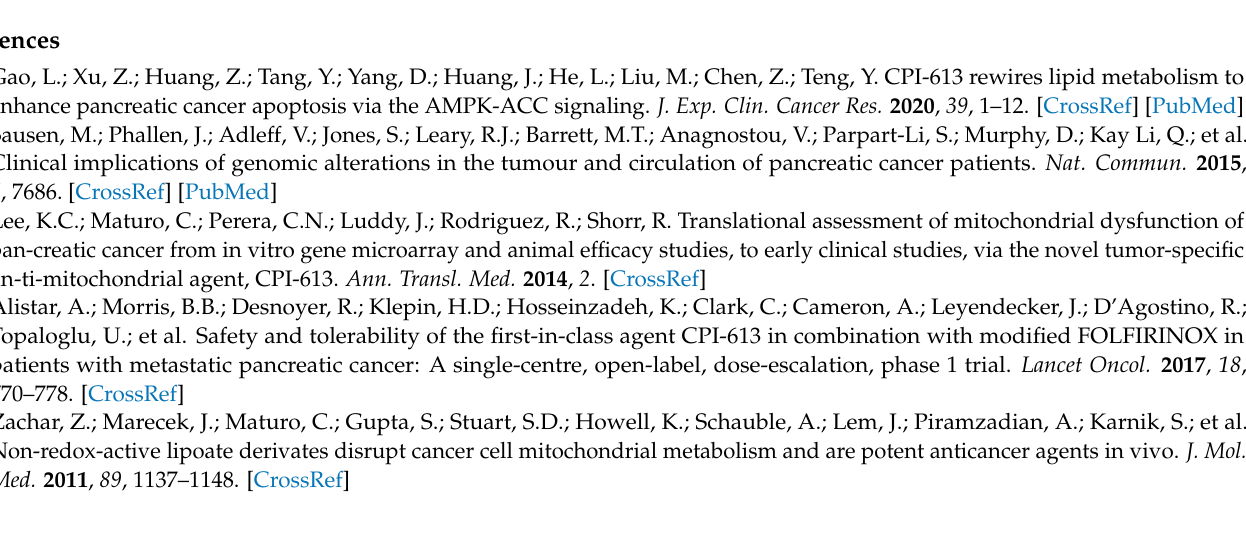
at room temperature). Data represent mean ± SD ( n = 3). Figure S3: Zeta-potentials of TTCI NPs constructed with TTCI :DSPE-PEG2000 at a molar ratio of 1:0.2 (DLS at room temperature). Figure S4: Size distribution of TTCh NPs after treatment with 700 mM H 2 O 2 for different times. Figure S5: Images of the BxPC-3 cells treated with Rhodamine B-loaded TTCI / Rho NPs at a concentration of 20 µ M for 0.5, 2, and 4 h, respectively. For each row, left: TTCI / Rho NPs; middle: bright field; right: merged image. The images were captured by high content analysis system-operetta CLS TM (A). Scale bars: 50 µ m. The mean intensity of rhodamine fluorescence in the images at different incubation times as calculated using imageJ software (B). Figure S6: Mitochondria-targeting ability of TTCI / NR NPs in vitro: Images of the BxPC3 cells treated with TTCI / NR NPs at the concentration of 20 µ M for 0.5, 2 and 4 h captured by high content analysis system-operetta CLS TM . For each row, from left to right: TTCI / NR NPs; mitochondria stained by MitoTracker Green; merged image. Scale bars: 50 µ m. Figure S7: Cell viability of AsPC-1 (A) and PANC-1 (B) cells after being treated with different concentrations of TTCI NPs and TTCh NPs for 48 h. Data represent mean ± SD ( n = 3). Figure S8: Digital phase contrast images of living BxPC-3 cells (D) treated with PBS, 20 µ M TTCI NPs, 50 µ M TTCI NPs and 50 µ M CPI-613 at different times. Digital phase contrast images were captured by high content analysis system-operetta CLS TM . Scale bar: 100 µ m and 50 µ m (for enlarged images). Figure S9: In vitro cytotoxicity of TTCI prodrugs (A) and TTCI NPs (B) at various concentrations against BxPC3 cells after 48 h incubation. Digital phase contrast images of living BxPC3 cells were captured by high content analysis system-operetta CLS TM treated with TTCI prodrugs and TTCI NPs at various